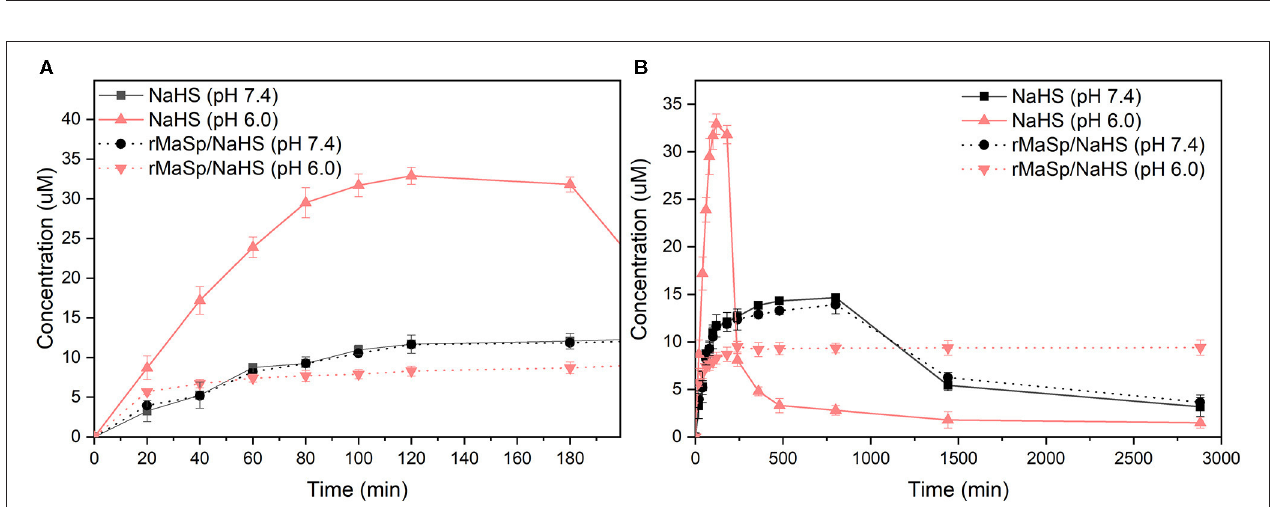
FIGURE 3 | H 2 S releasing kinetics of donor NaHS vs. rMaSp/NaHS fiber (with 10% NaHS) under pH 7.4. (A) Short-term releasing profile (0–180min). (B) Longer-term releasing profiles (0–2,880min).